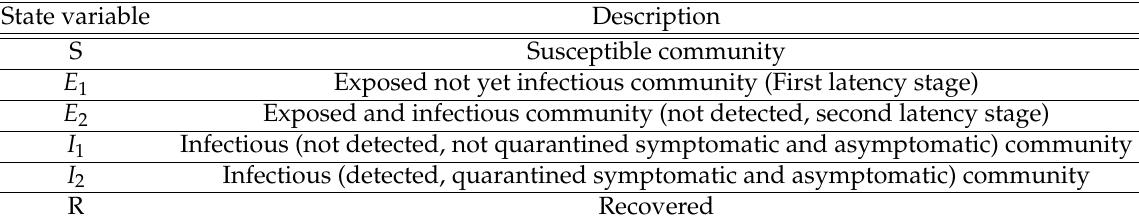
Table 1. Parameters for numerical simulation